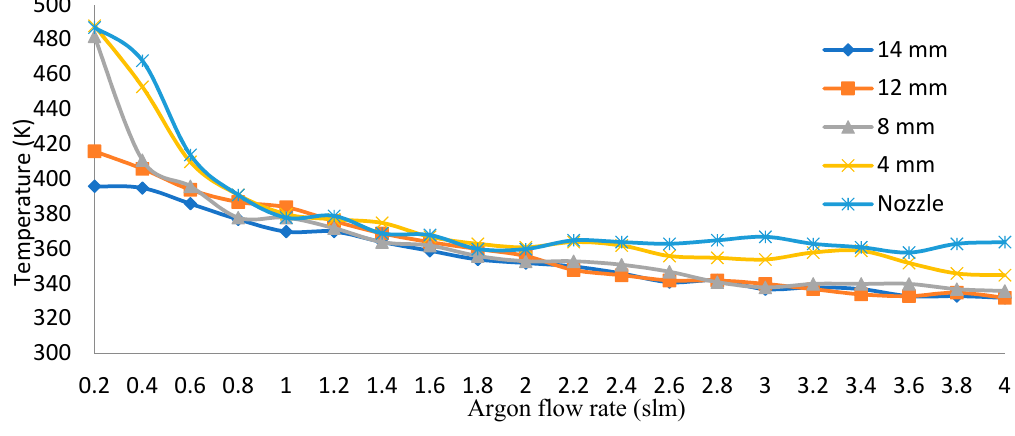
Figure 9. Axial temperature distributions for argon at different applied flow rates.